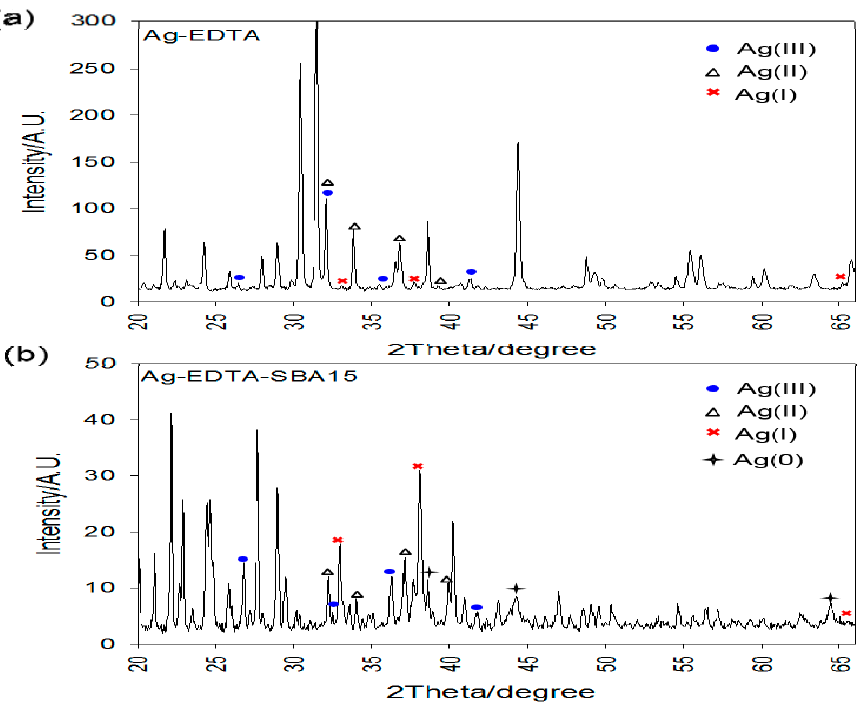
Figure 4. XRD patterns of high valence Ag samples: ( a ) Ag-EDTA and ( b ) Ag-EDTA-SBA-15.